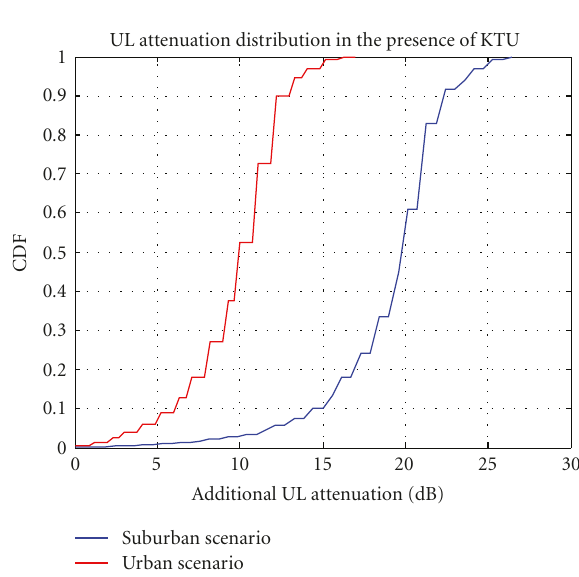
Figure 2: Distribution of adaptive UL attenuation gain when there is Kitchen Table MUE.